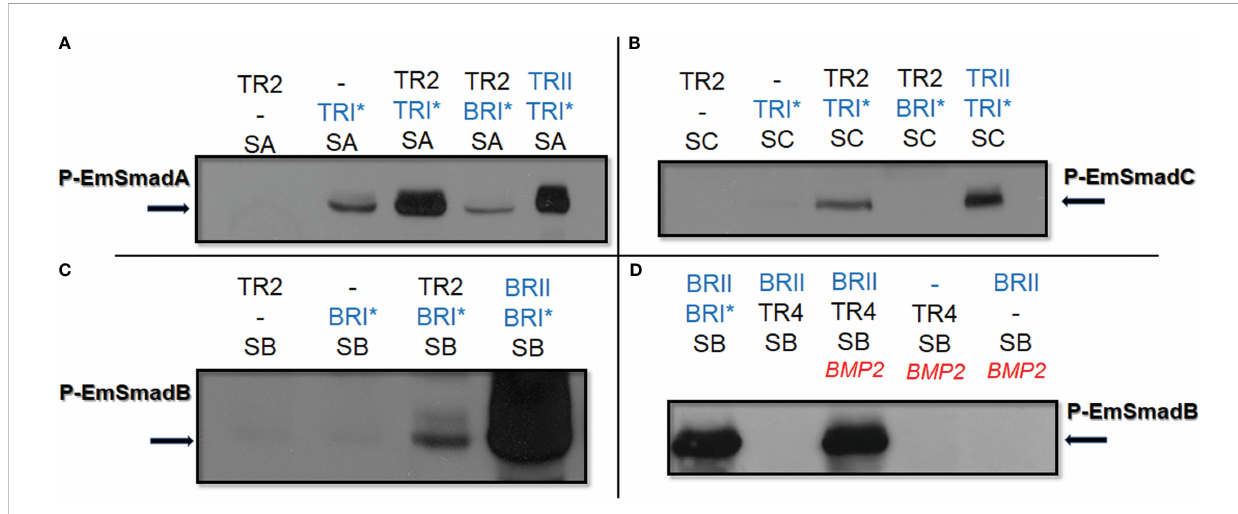
FIGURE 2 Functional interaction of human and Echinococcus TGF b /BMP receptors. Echinococcus and human TGF b /BMP receptors were co-expressed with Echinococcus R-Smads in HEK293 T cells either with or without stimulation by exogneous human cytokines. Cell lysates were subjected to PAGE and Western blot analysis using phospho-speci fi c antibodies. Displayed are the results for EmSmadA (A) , EmSmadC (B) , and EmSmadB (C) upon co- expression with EmTR2 and different human TGF b /BMP receptors (as indicated). In (D) , results for EmSmadB upon co-expression with EmTR4 and the human type II BMP receptor (BRII) are shown. Human type II receptors for BMP (BRII) as well as constitutively activated type I receptors for BMP (BRI*) and TGF b (TRI*) are shown in blue. Abbreviations for Echinococus receptors (in black) indicate EmTR2 (TR2) and EmTR4 (TR4), abbreviations for R-Smads are SA (EmSmadA), SB (EmSmadB), and SC (EmSmadC). The addition of exogenous human BMP2 is indicated in red. Arrows to the left and right indicate the phosphorylated R-Smad forms. In all cases comparative amounts of total R-Smads, as measured using an anti-Myc-tag antibody, were applied to the gel. Results show representative examples of experiments performed in triplicates. -, not